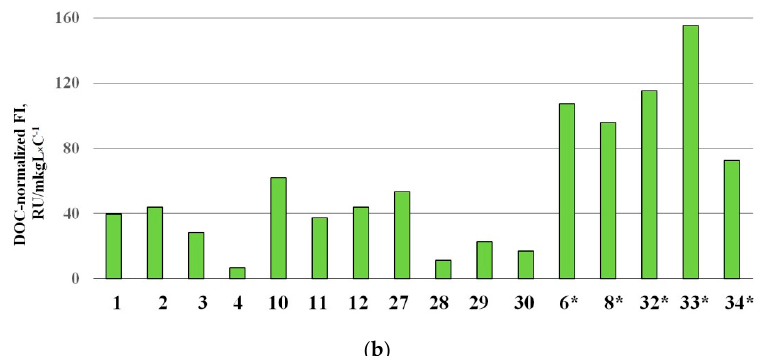
Figure5. DistributionoffluorescentDOM(fDOM).( a )ThemolecularfractionsoffDOM;( b )Distribution Figure 5. Distribution of fluorescent DOM (fDOM). ( a ) The molecular fractions of fDOM; ( b )